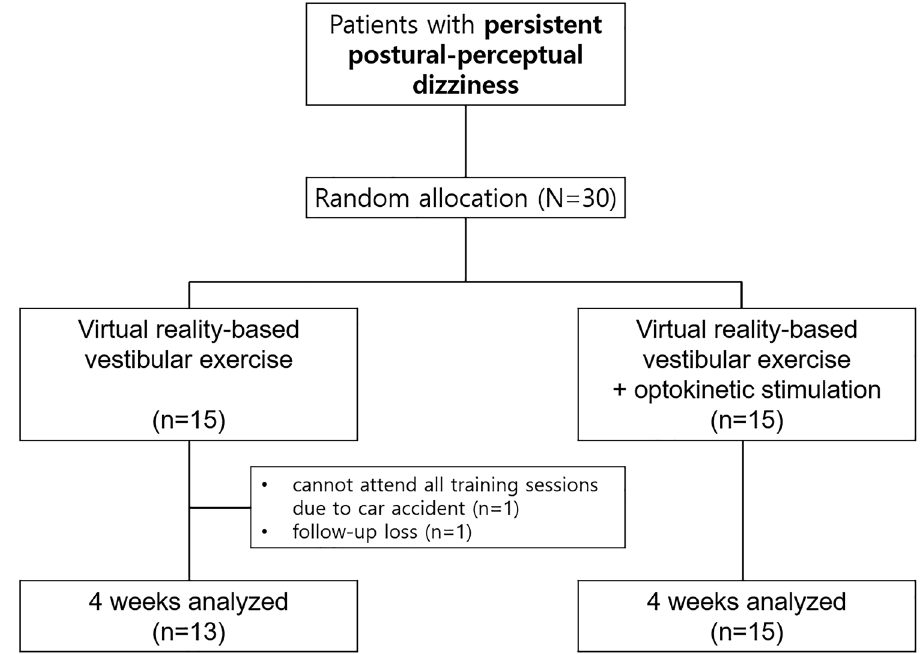
Figure 1. Consort diagram.